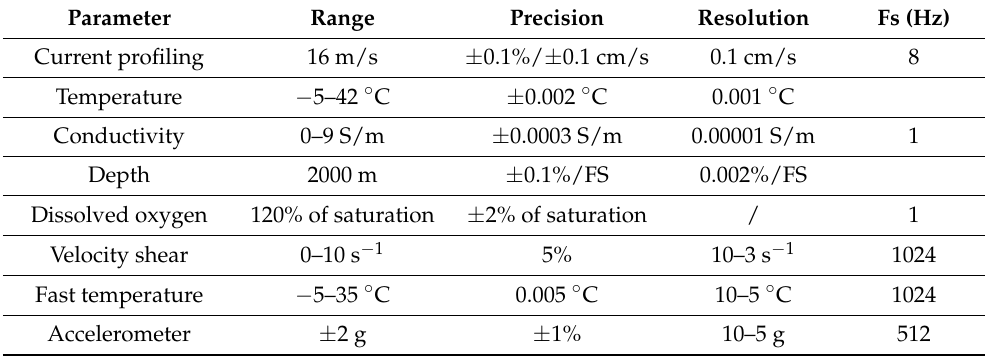
Table 1. The hybrid AUV measured parameters, sensor type, and sensor specifications. Parameter Range Precision Resolution Current